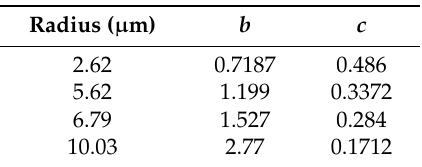
Figure 5. Fitting results with the novel deviation model: ( a ) R = 10.03 μ m; ( b ) R = 6.79 μ m; ( c ) R = 5.62 μ m; ( d ) R = 2.62 μ m. Table 1. Parameters ( b and c ) versus radius of micro tubes.